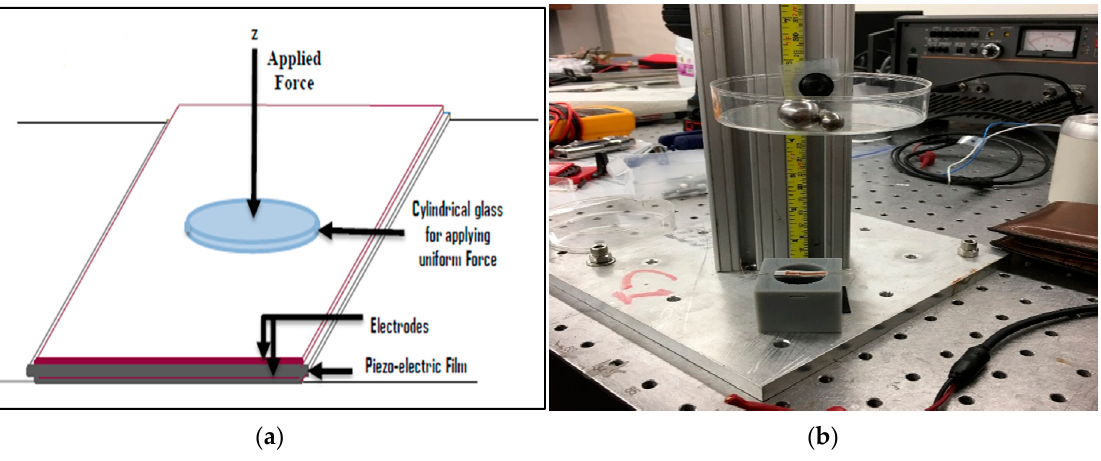
Figure 4. ( a ) Schematic of impact test, ( b ) Impact test setup .